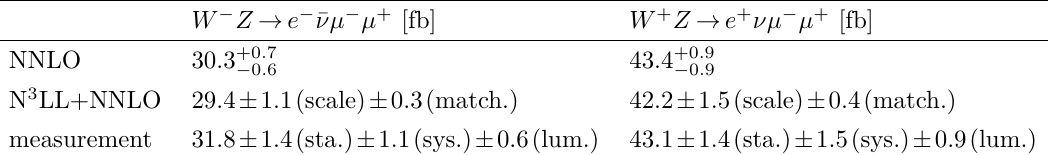
Table 6 . Comparison of total fiducial WZ cross-section predictions at NNLO, N 3 LL+NNLO with the CMS measurements taken from tables 8 and 9 of ref. [22]. Fiducial cuts are as in table